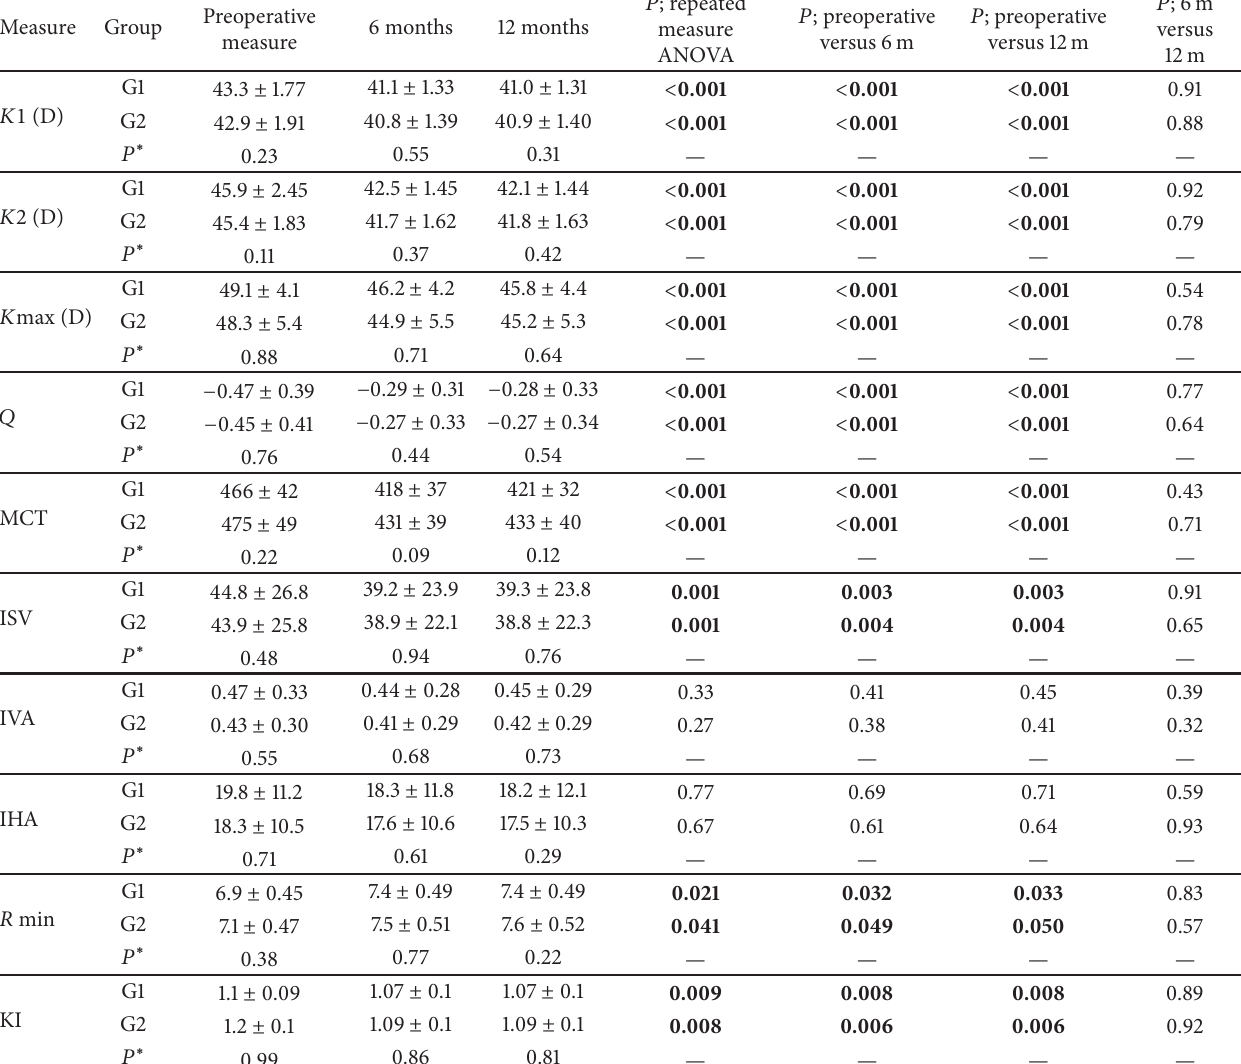
Table 4: Preoperative and postoperative topographical (Pentacam) parameters (mean ± SD) in the 2 studied groups 6 months and 12 months following the full